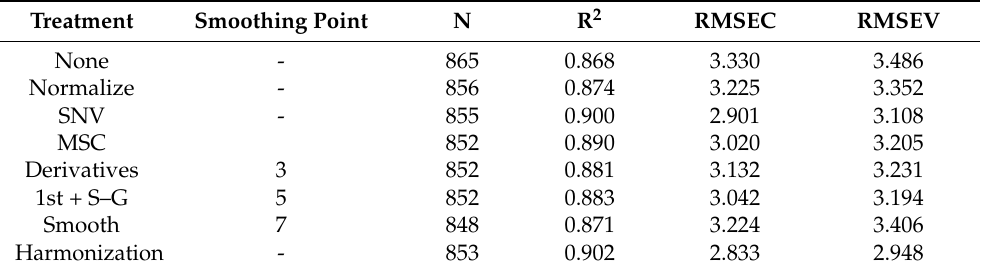
Figure 2. Analysis of single maize kernels by NIR spectral analysis. Example of the direct NIR spectra ( A ); raw NIR spectrum data treated by SNV and SG first derivative ( B ). The horizontal axis shows the wavelength and the vertical axis shows the reflectance (log [1/R]). Table 2. Results of amylose content determination in single maize kernels based on various factors with different spectral pretreatments by PLS models